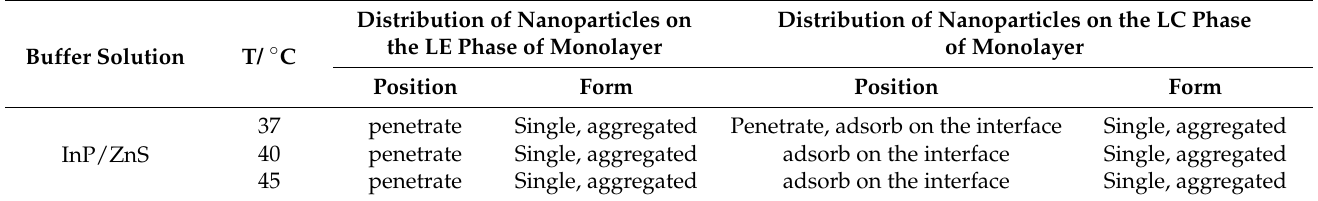
Table 3. The distribution of nanoparticles on the LE and LC phase of the DPPC/DPPG